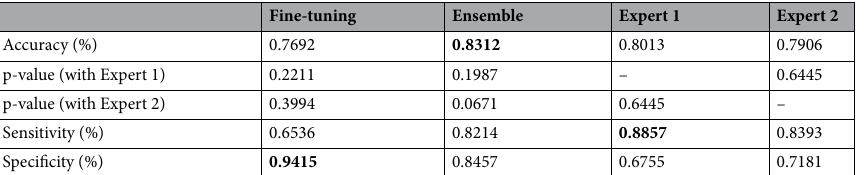
Table 1. Prediction comparisons of the single fine-tuning model, the ensemble model, and two human experts. The case with the highest value was bolded. Ensemble learning shows improved model accuracy to be slightly higher than that of two human experts. P-values: McNemar’s test using the results of the two experts as a reference.